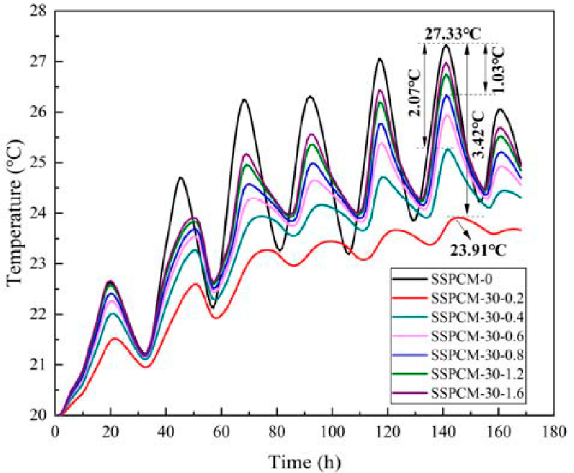
Figure 15. The internal surface temperatures of the SSPCM granary wall with different thermal con- ductivities.